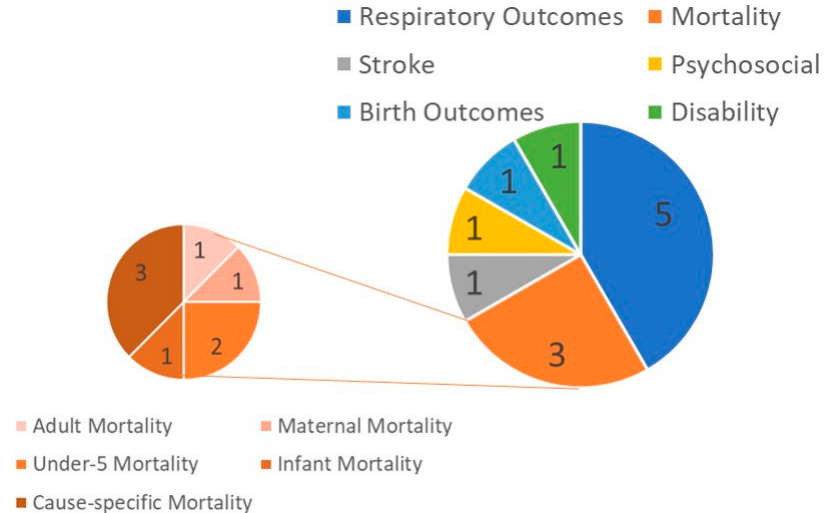
Figure 3. Distribution of types of study by health outcome categories. The smaller pie chart represents the number of mortality outcomes examined within the three different mortality studies identified in our review of the literature.